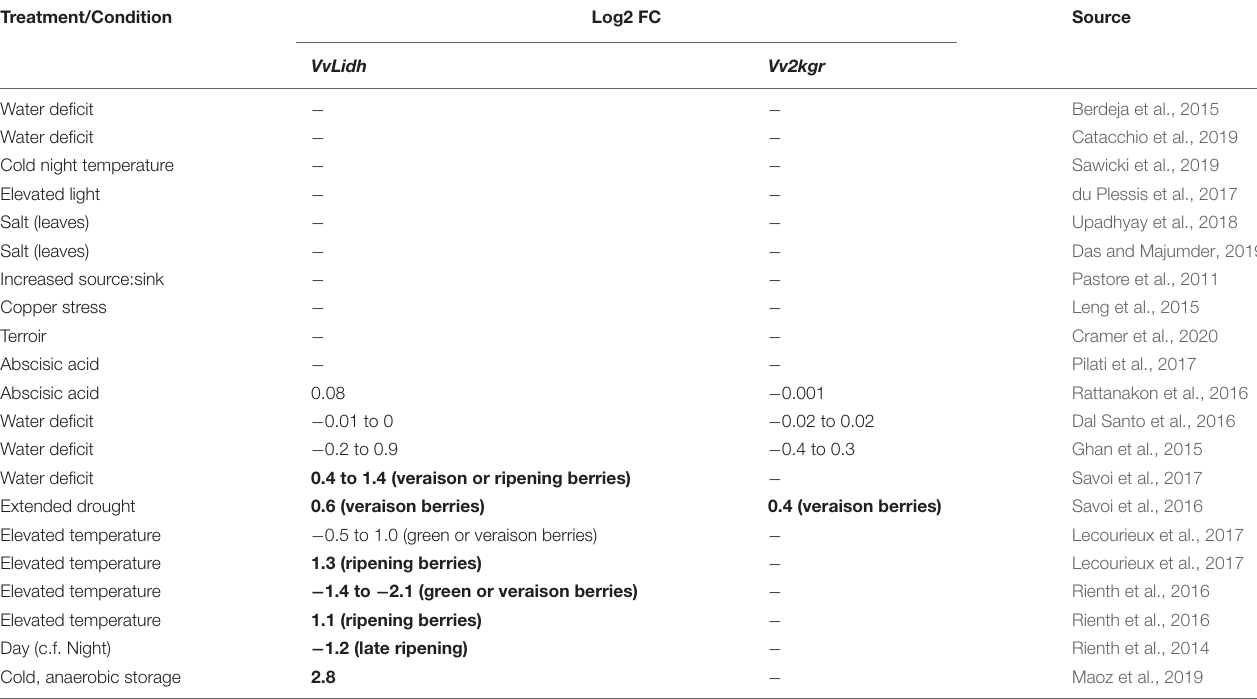
TABLE 1 | Summary of transcriptomic responses of VvLidh and Vv2kgr to environmental cues.